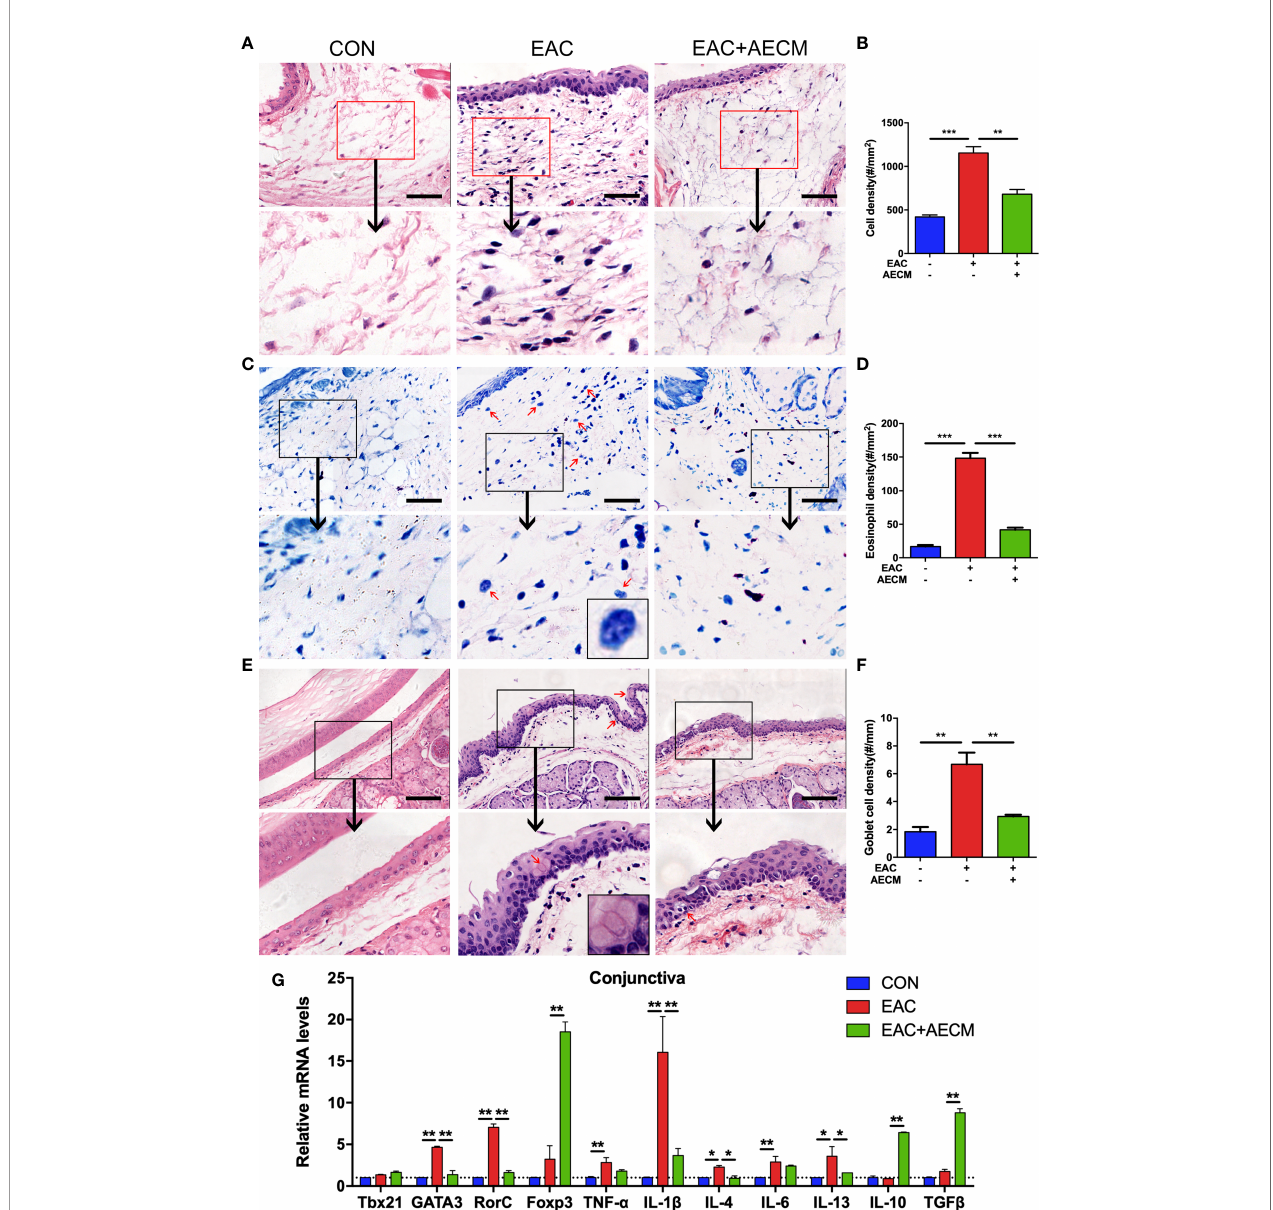
FIGURE 2 | AECM treatment alleviated in fl ammatory response in EAC mice. (A) Representative image of H&E staining of the conjunctiva in mice in different treatment groups. Scale bar, 50 m m. (B) Quanti fi cation of cell density in the conjunctiva of mice in each group. The data are expressed as the mean ± SEM. At least six representative sections of the conjunctiva were counted. At least three mice were used in each group. (C) Giemsa staining conjunctiva of mice in different treatment groups. Red arrows indicate eosinophils. Scale bar, 50 m m. The magni fi cation black box at the bottom of the middle pattern represents a large eosinophil with bilobed nucleus. (D) Quanti fi cation of eosinophil density of the conjunctiva of mice in each group. (E) H&E staining of conjunctiva of mice in different treatment groups. Red arrows indicate goblet cells with vacuole. Scale bar, 100 m m. The magni fi cation black box of the middle pattern represents a magni fi cation image of goblet cells with vacuole. (F) Quanti fi cation of goblet cell density in the conjunctiva of mice in each group. (G) Real-time PCR analysis of mRNA levels of cytokines and marker genes of immune cells in conjunctiva of mice in different groups. The mRNA levels of genes in CON group were set as 1, and the data are expressed as the mean ± SEM, n = 3. * P < 0.05, ** P < 0.01, and *** P <